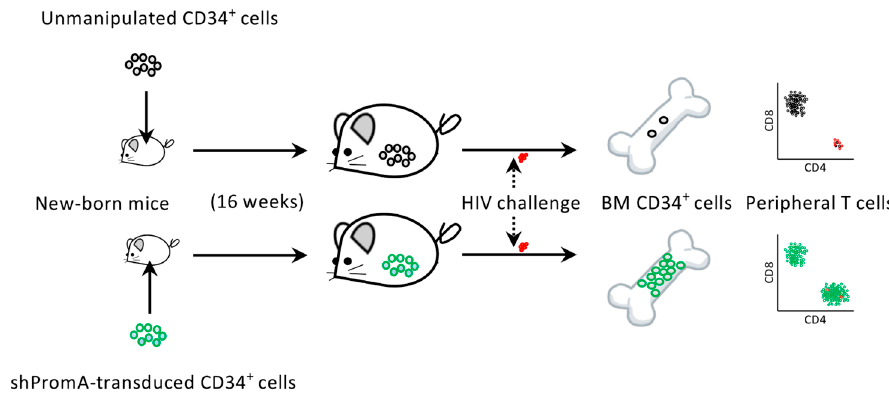
Figure 3. Summary of the humanized mouse study to test the efficacy of shRNA PromA (shPromA) [26]. Newborn NOD/SCID/Jak3 null mice were intrahepatically transfused with unmanipulated cord-derived CD34 + cells or CD34 + cells lentivirally transduced with shPromA. Those mice showing engraftment of human cells were challenged with CCR5-tropic HIV-1 JRFL . Two weeks after the challenge, the mice were sacrificed and their bone marrow (BM) CD34 + cells and peripheral T cells were analyzed. Interestingly, mice transplanted with unmanipulated CD34 + cells showed unexpectedly low BM CD34 + cell counts 2 weeks after HIV infection, with concomitant depletion of peripheral CD4 + T cells. On the other hand, mice engrafted with shPromA-expressing CD34 + cells showed preserved BM CD34 + cell and peripheral CD4 + T-cell populations at 2 weeks post challenge.